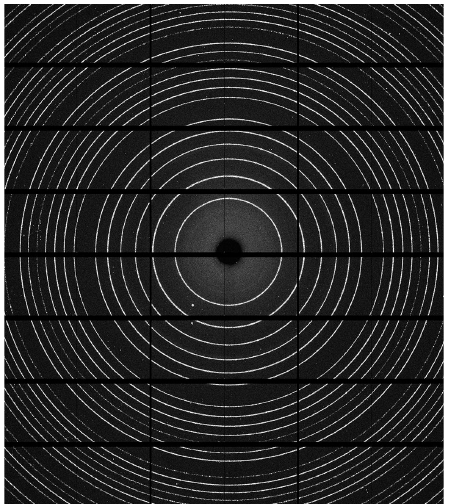
Figure 5 Diffraction pattern collected from a LaB 6 (NIST SRM 660b) powder calibration standard in forward scatter position used for energy calibration (instrument settings: beam size 2 m m (cid:3) 15 m m, E = 31.52 keV, detector at (cid:2) = (cid:3) = 0 (cid:2) , radius of 330